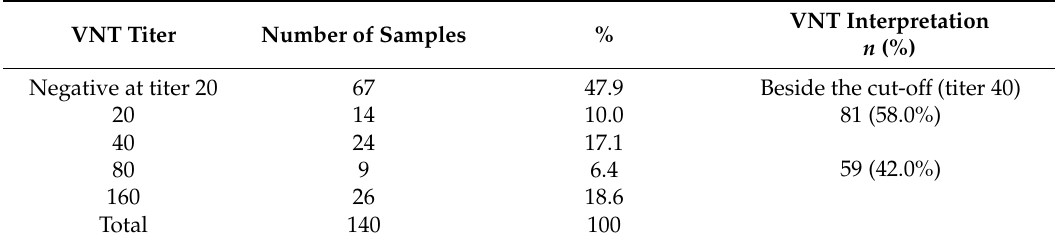
VNT Interpretation n (%)